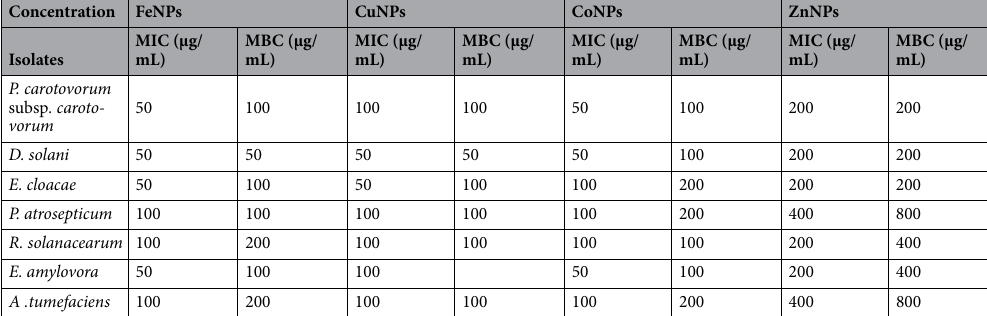
Table 5. Minimum inhibitory concentrations (MICs) and minimum bactericidal concentrations (MBCs) of tested metals NPs against some phytopathogenic bacteria.